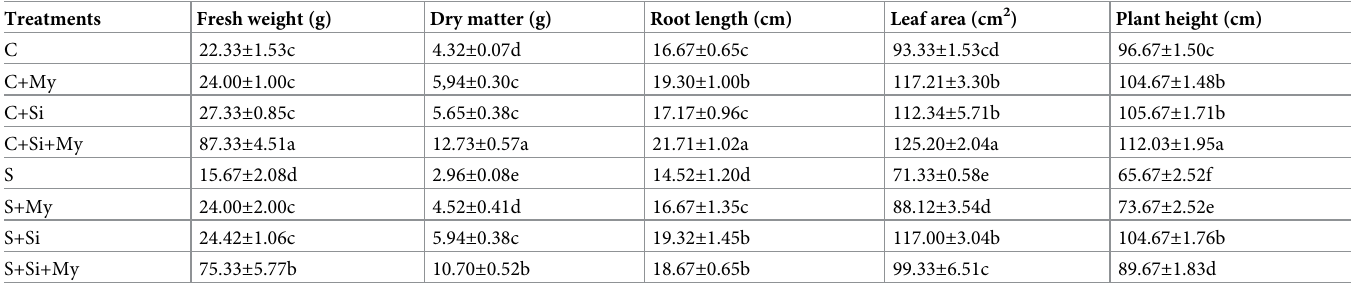
Table 1. Variation among the different treatments for morphological traits of Brassica juncea when treated with silicon and mycorrhizal inoculation of under water stress in the influence of silicon and mycorrhizal inoculation.